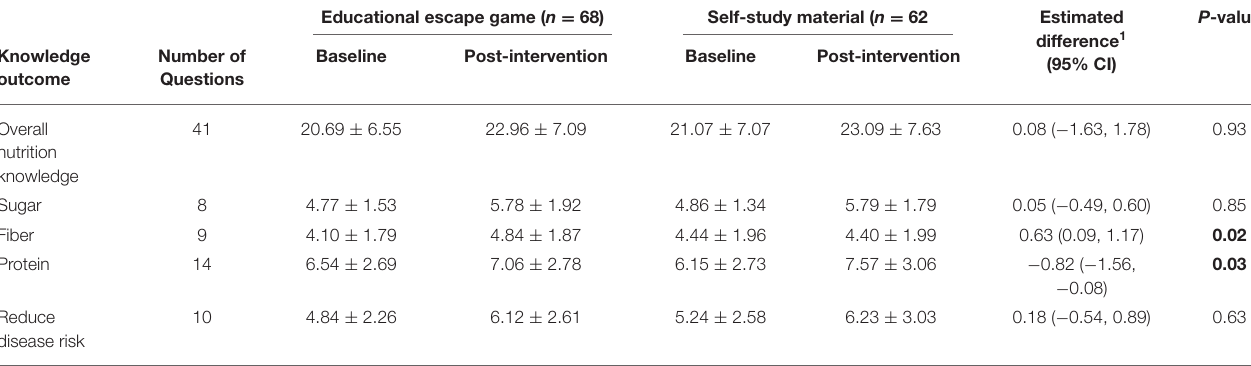
TABLE 2 | Comparison of mean baseline and post-intervention knowledge scores in educational escape games and self-study intervention